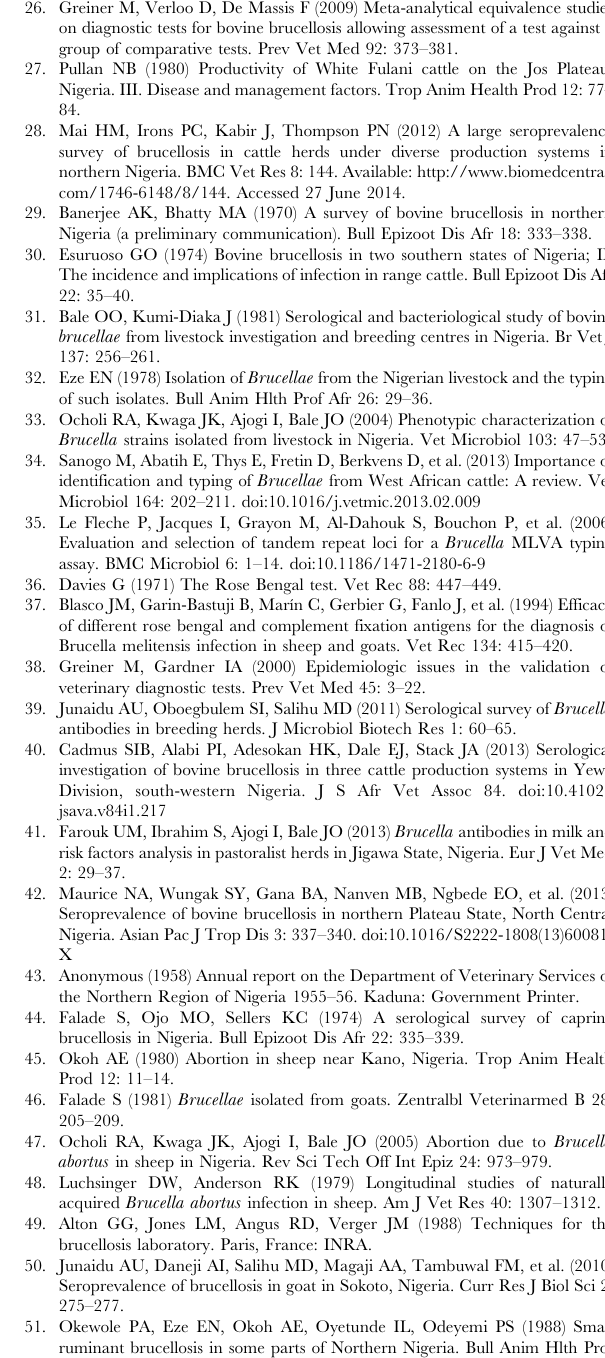
Table S15 Brucellosis bacteriology studies in sheep and